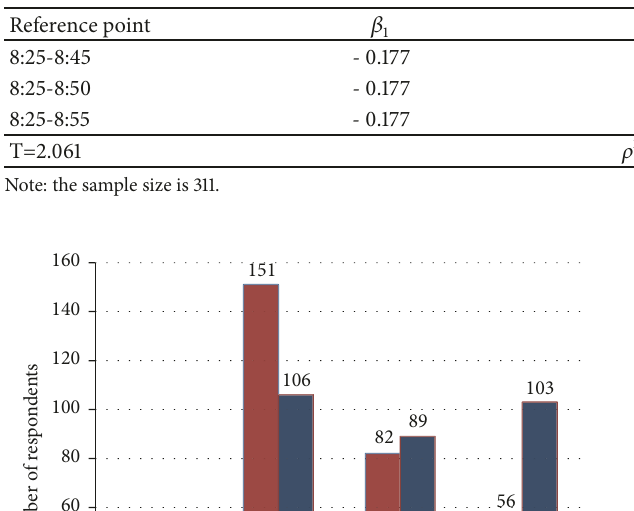
Table 1: Calibration results of model parameters.